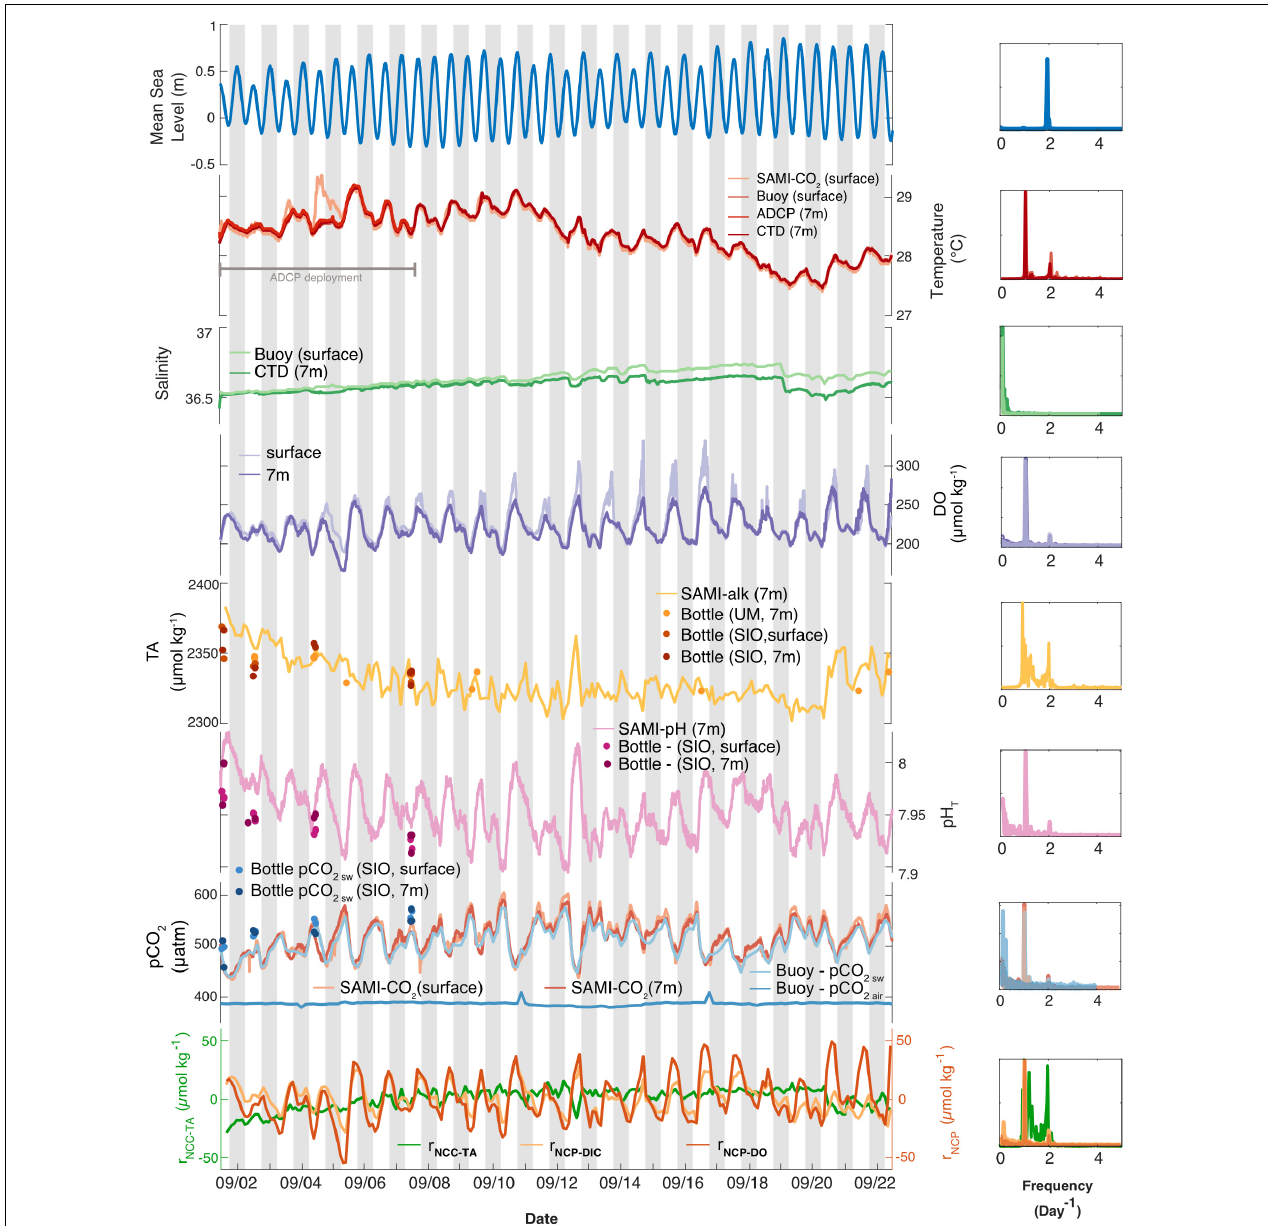
FIGURE 3 | (Left) Temporal variability in environmental conditions and seawater chemistry on Hog Reef for September 2017 at surface (lighter colors) and bottom (darker colors). Temperature, salinity, dissolved oxygen, TA, pH T , and p CO 2 were measured with autonomous moored sensors. Measurements of bottom temperature (at 7 m depth) from multiple sensors were essentially indistinguishable, thus only one was plotted. Measured TA and calculated pH T and p CO 2 from discrete TA and DIC seawater samples were plotted as circles (“SIO” samples were analyzed in the Andersson Lab at Scripps Institution of Oceanography and “UM” samples were analyzed in the DeGrandpre Lab at the University of Montana Missoula). Mean sea level data were accessed from the NOAA Tides and Currents Database (St. George’s Island). Relative NCC and NCP ( r NCC-TA , r NCP- DO , and r NCP- DIC ) were estimated from sensor-derived water chemistry data using a mean anomaly (as described in the text). Gray bars indicate nighttime hours. ( Right ) Lomb-Scargle periodograms of autonomous moored sensor parameters as well as calculated r NCC-TA , r NCP- DO , and r NCP- DIC .